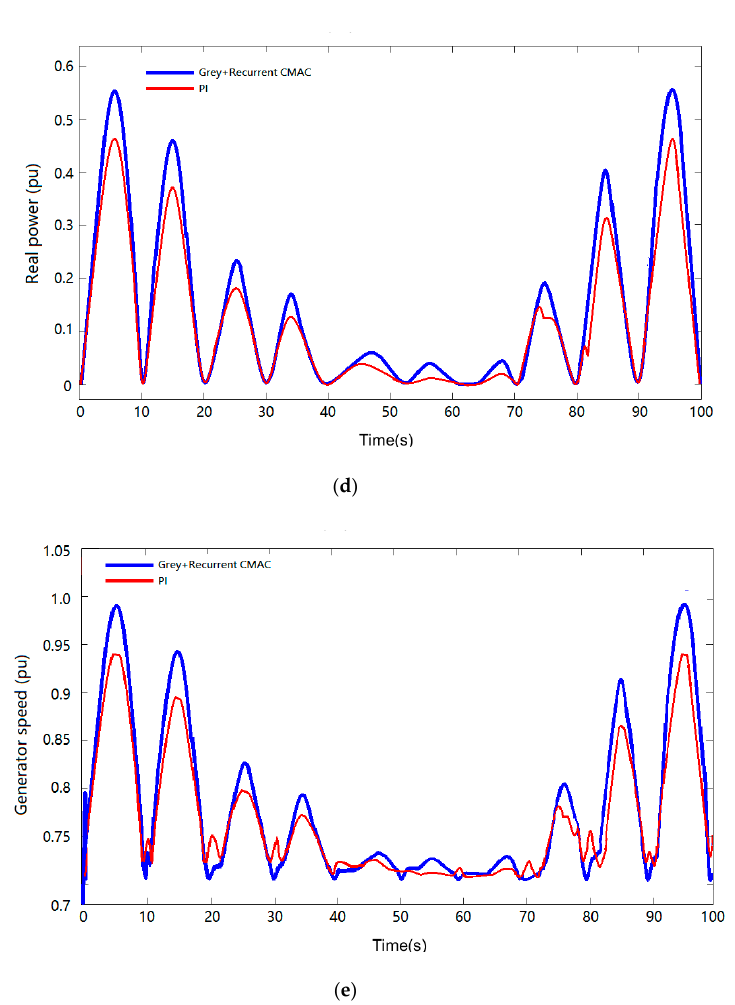
Figure 5. Dynamic responses to pressure drop for the studied system: ( a ) the pressure variation, ( b ) the real power response of WECS (Case 1), ( c ) Wells turbine’s rotor speed response (Case 1), ( d ) the real power response of WECS (Case 2), and ( e ) Wells turbine’s rotor speed response (Case 2). Table 2. Comparison results for five methods for the Wells turbine rotational speed change: (a) real power of WECS, (b) reactive power of WECS, and (c) dynamic voltage amplitude response of AC bus on power grid side.